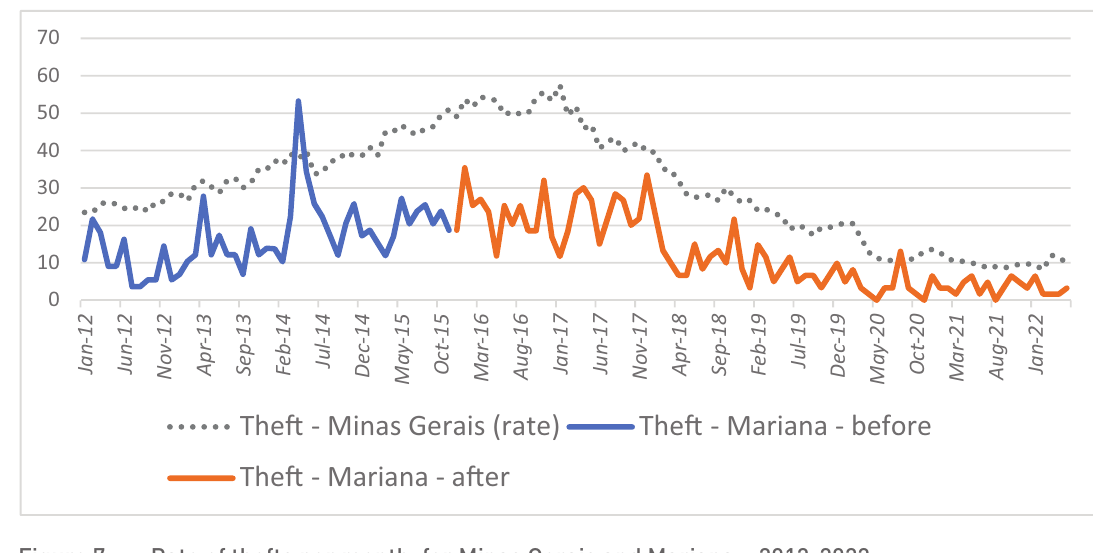
Figure 7. Rate of thefts per month, for Minas Gerais and Mariana – 2012- 2022 Source: Occurrences: Armazém Sisp (official data warehouse for Minas Gerais state public security system). Demographic data: IBGE.